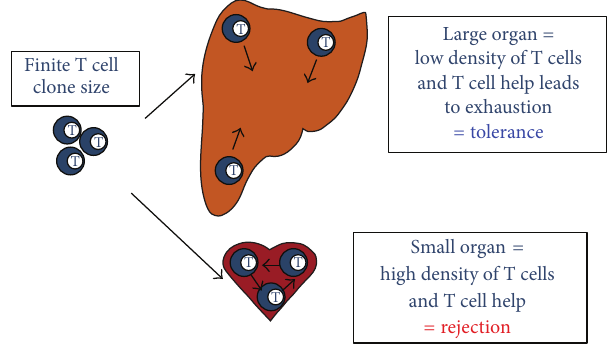
Figure 1: High antigen dose leads to tolerance by exhausting the finite T cell clone size. Transplantation of a smaller organ (e.g., a heart) results in rejection due to a high density of alloreactive T cells and sufficient T cell help. Grafting a large tissue mass or organ (e.g., a liver) leads to a low density of alloreactive T cells and T cell help, resulting in exhaustion of T cells and subsequent